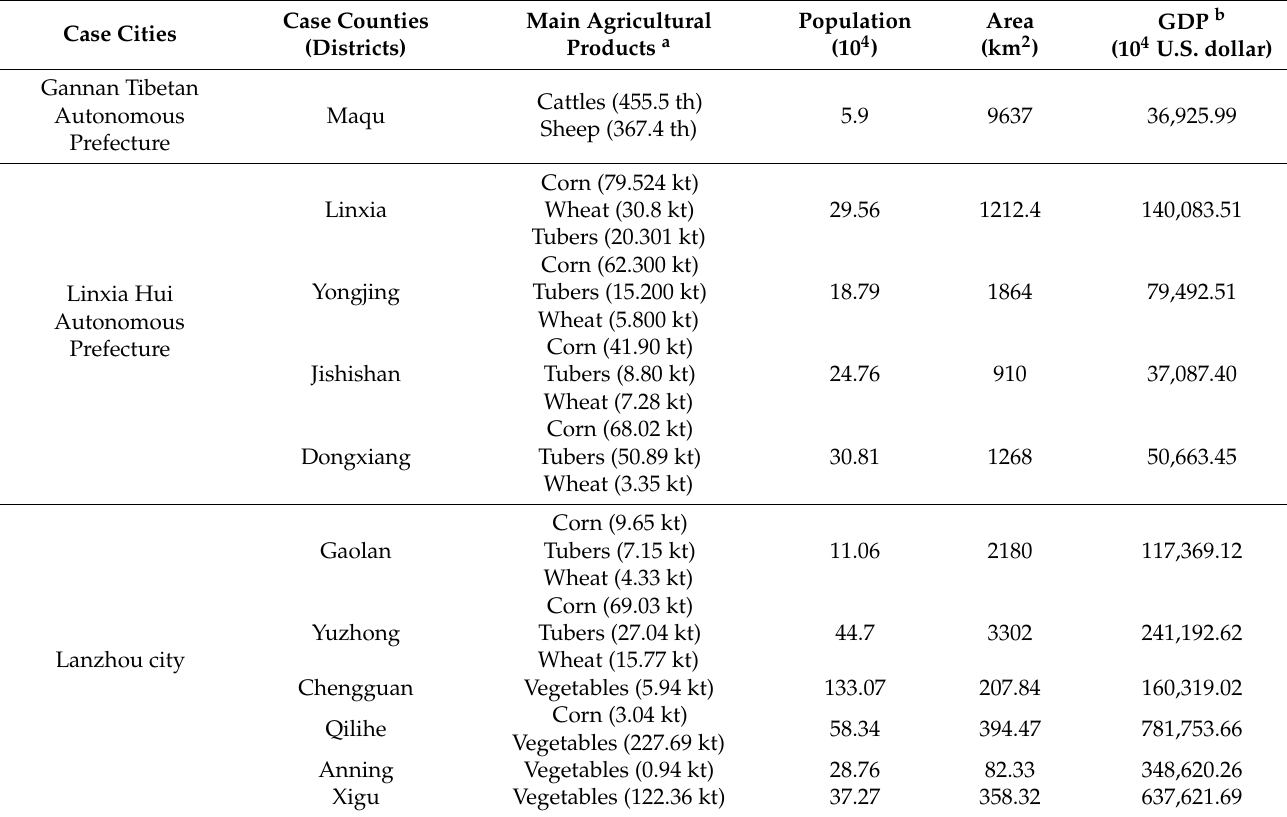
Figure 1. The location of 15 counties within The Main Stream Area Yellow River Basin in Gansu Province. Table 1. Brief profiles of studied counties (districts).